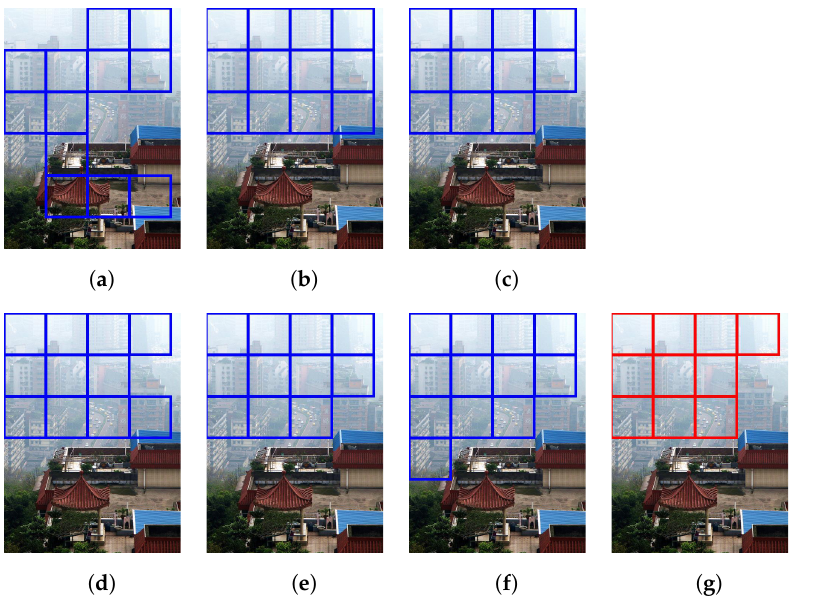
Figure 16. Selection of representative hazy patches based on: ( a ) mean subtracted contrast nor- malized, ( b ) sharpness, ( c ) contrast, ( d ) entropy, ( e ) dark channel prior, and ( f ) saturation features. ( g ) Selected patches.